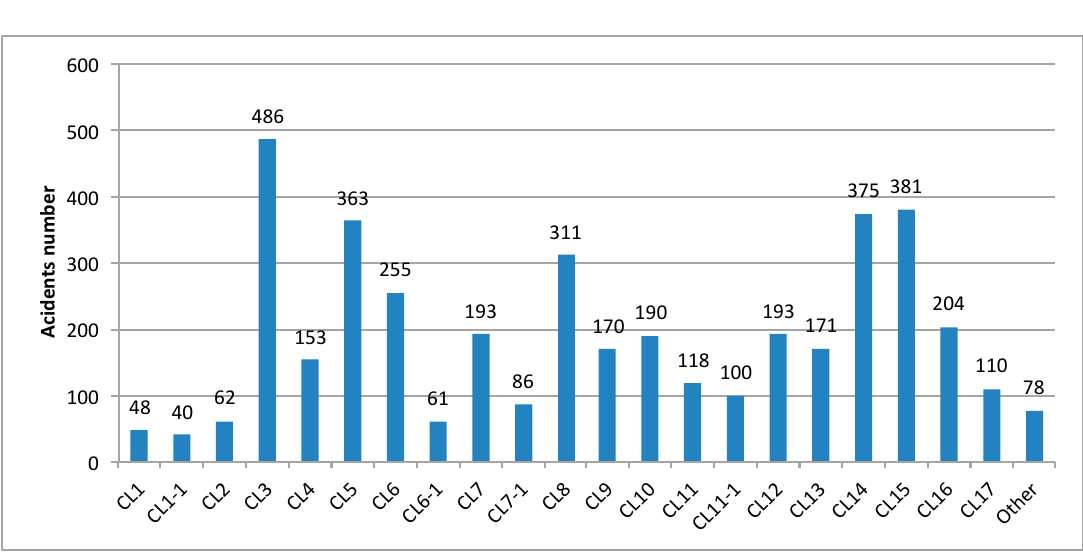
Figure 5. Number of events per cluster.